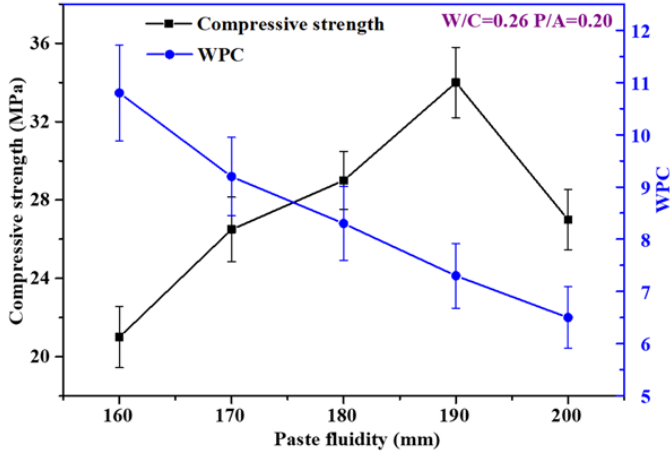
Figure 2. Relationship between compressive strength and paste fluidity (square solid line) and WPC and paste fluidity (bullet solid line) (Note: P/A was fixed at 0.20).